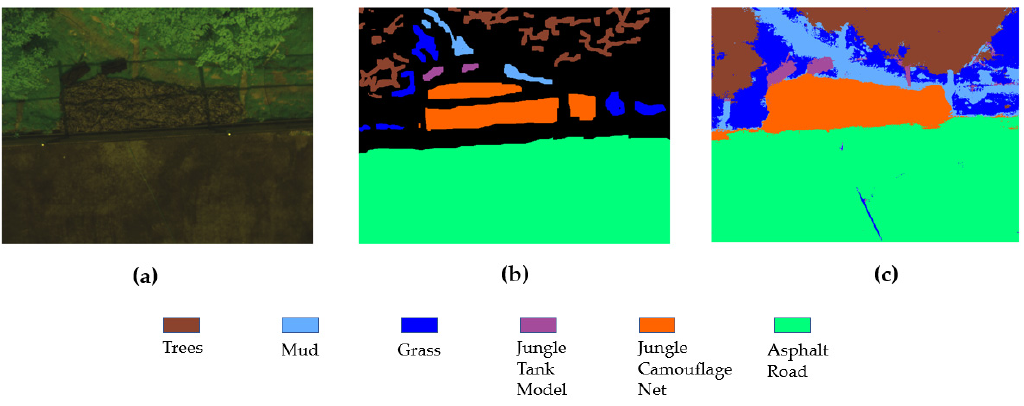
Figure 14. Visualized results of our flight experiment. ( a ) The false color composite image; ( b ) the ground truth image; ( c ) the INAPC classification map.